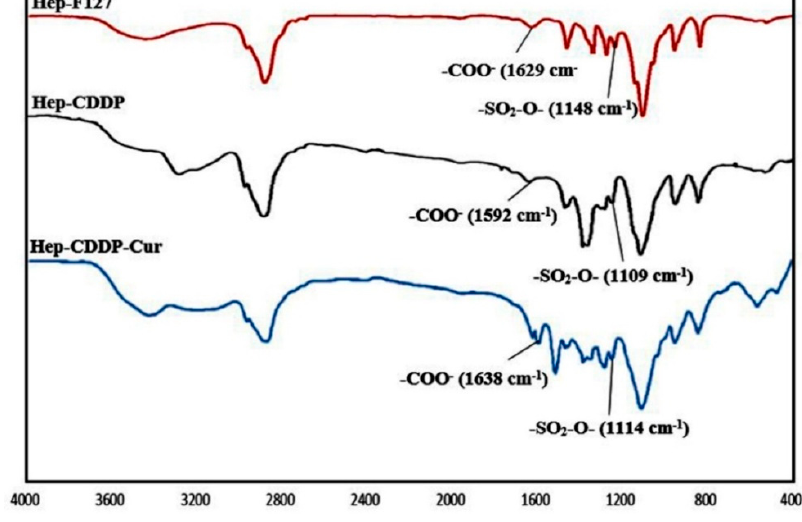
Figure 2. FT-IR spectra of Hep-F127; Hep-F127/CDDP;